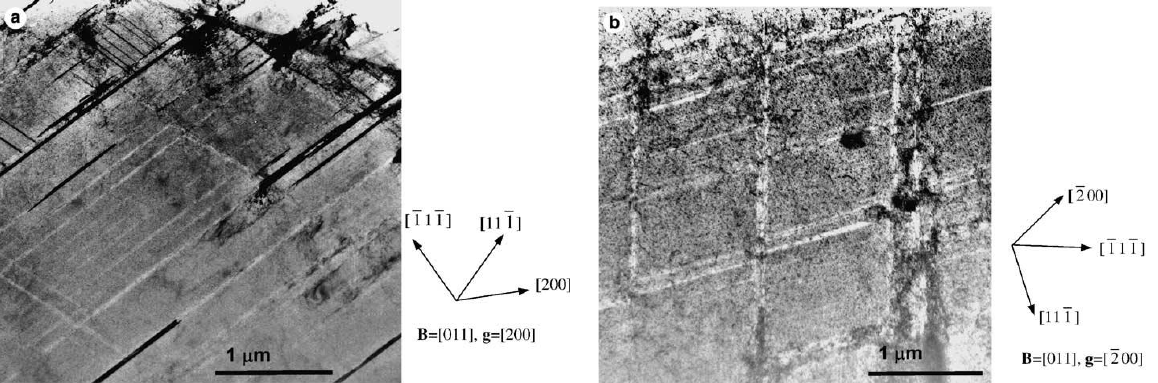
Figure 8. Examples of strain localisation and deformation twins in neutron-irradiated 316 SS after tensile testing: ( a ) mixture of twins and dislocation channels in 316 stainless steel irradiated.to 0.15 dpa and strained 6%; ( b ) intersecting arrangement of dislocation channels in 316 stainless steel irradiated to 0.78 dpa and strained 32%. Modified from [19].